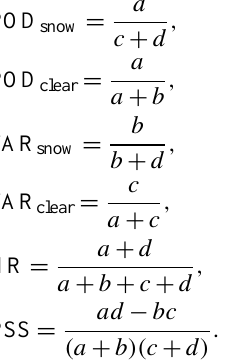
Figure 4. Statistical scores for Swerad using CloudSat as a refer- ence. The scores are shown as a function of distance to the nearest radar as well for different lower limits of the snowfall rate. The panels show the probability of detecting snow (a) , the probability of detecting clear conditions (no precipitation) (b) , false alarm rate of snow (c) , false alarm rate of clear conditions (d) , hit rate (e) , and Pierce’s skill score (f)